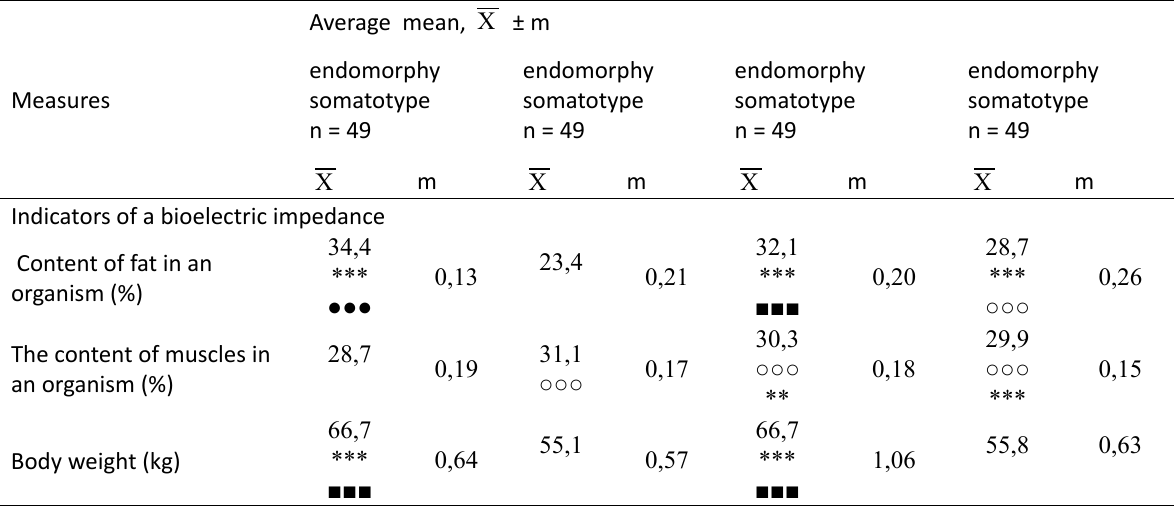
Table 2. The body component structure and women body weight